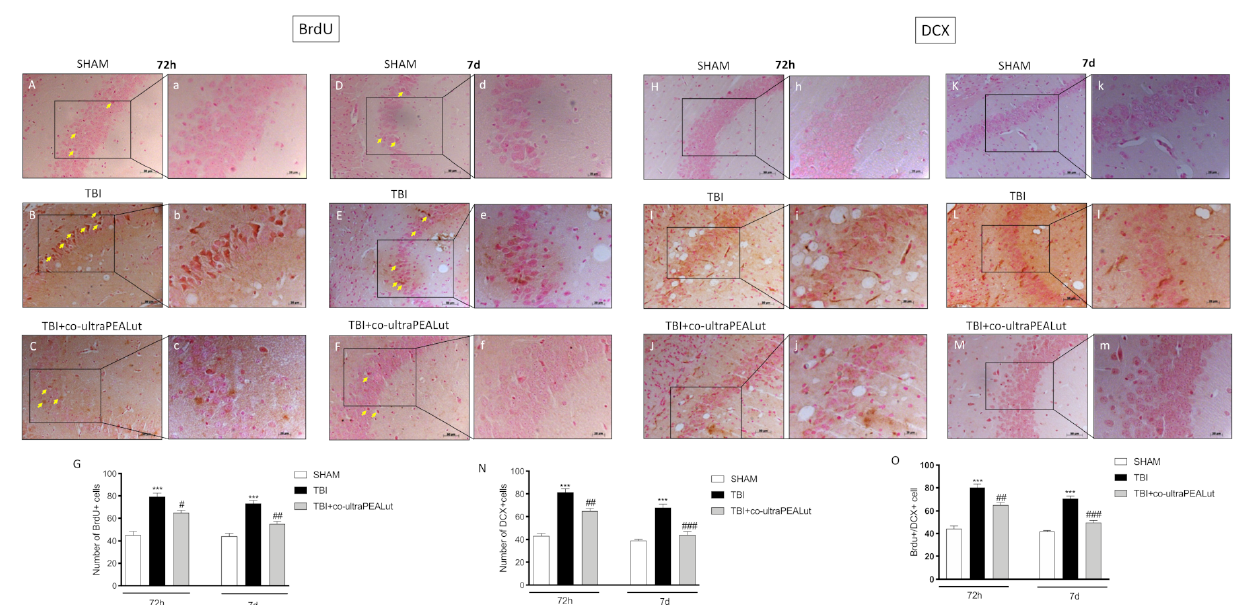
Figure 2. Effect of co-ultra PEALut on newly born cell and mature cell proliferation. Cell proliferation was increased at 72 h and 7 d post TBI ( B , E , respectively, G ) compared to sham groups ( A , D , respectively, G ). Co-ultra PEALut treatment modulated this process returning to baseline ( C , F , respectively, G ). Scale bar = 0.5 mm ( A – F ) and 20 µ m ( a – f ) for higher magnification. One-way ANOVA test. # p < 0.05 vs. corresponding TBI group. ## p < 0.01 vs. corresponding TBI group. *** p < 0.001 vs. corresponding Sham group (F 72h = 36.4 and F 7d = 38.7). DCX+ cells increased at 72 h and 7 d post-TBI ( I , L , respectively, N ) compared to sham groups ( H , K respectively, N ). Co-ultra PEALut treatment modulated cell maturation comparably to the sham group ( J , M respectively, N ). BrdU/DCX expressing cell ratio ( O ). Yellow arrows indicate the positive staining for BrdU. For IHC analyses, the reaction was revealed by a chromogenic substrate (DAB), and counterstaining with Nuclear Fast Red. For a graphic display of the densitometric analyses, the percent of positive staining (DAB brown staining) was measured by computer-assisted color image analysis. The percentage area of immunoreactivity (determined by the number of positive pixels) was expressed as percent of the total tissue area (red staining) within five random fields at a 40 × magnification. Data are expressed as Mean ± SEM from N = 10 mice for each group. Scale bar = 0.5 mm ( H – M ) and 20 µ m ( h – m ) for higher magnification. One-way ANOVA test. ( N ) ## p < 0.01 vs. corresponding TBI. ### p < 0.001 vs. corresponding TBI. *** p < 0.001 vs. corresponding sham group (F 72h = 60.9 and F 7d = 37.9); ( O ) ## p < 0.01 vs. corresponding TBI. ### p < 0.001 vs. corresponding TBI. *** p < 0.001 vs. corresponding Sham group (F 72h = 5.57 and F 7d =